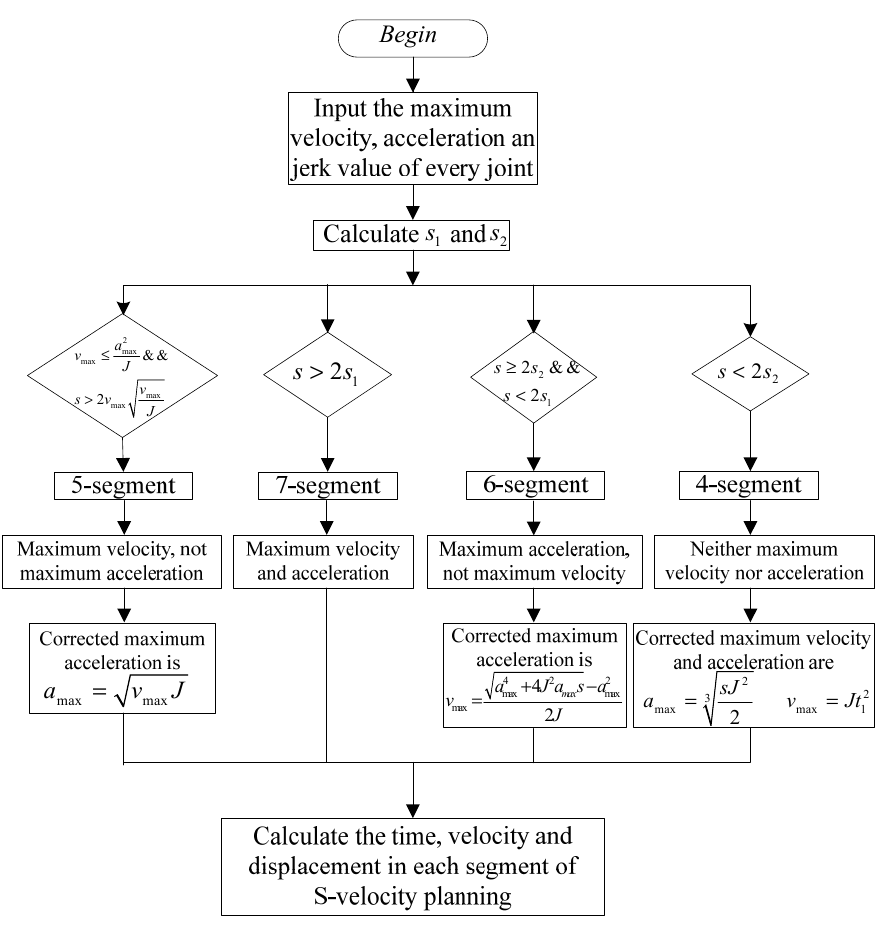
Figure 4. S-velocity planning algorithm flow chart.